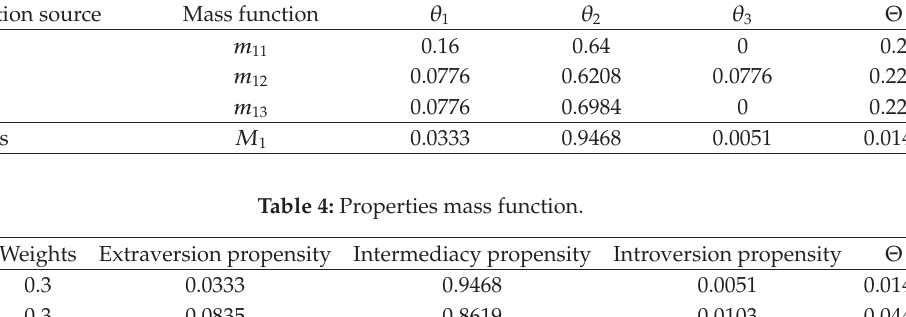
Table 3: Synthesis conditions of “reaction judgment indexes” mass function.